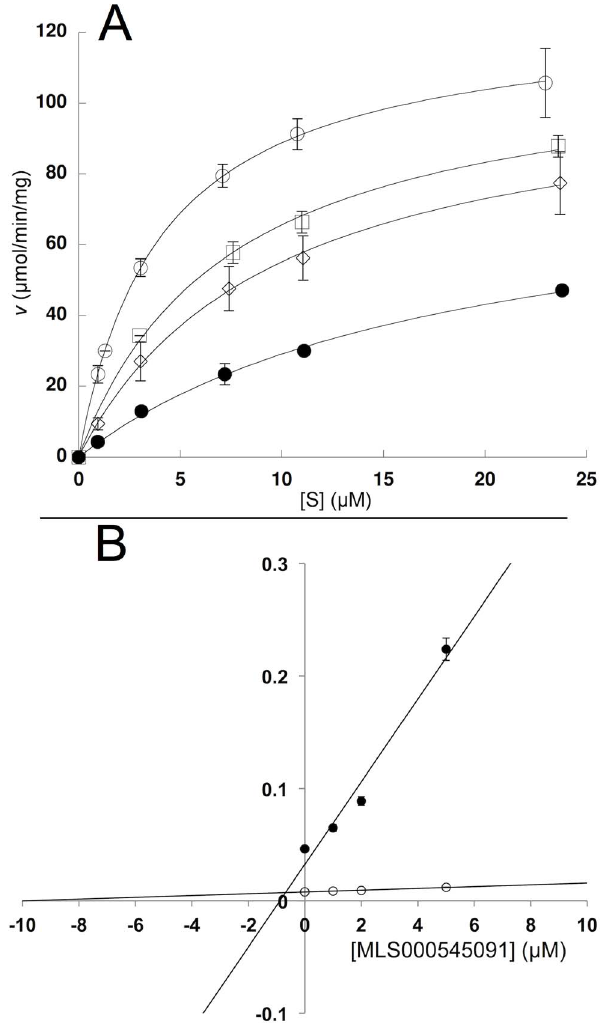
Figure 4. Steady-state kinetics data for the determination of K i and K i 9 for 15-LOX-2 with MLS000545091. (A) Initial enzymatic rate ( m mol/min/mg) versus substrate concentration ( m M) at inhibitor concentrations of 0 m M (open circles) 1 m M (open squares) 2 m M (open diamonds) and 5 m M (closed circles) fitted to the Henri–Michaelis– Menten equation to yield V max ( m mol/min/mg) and V max / K M (mol/min/ mg/ m M). All measurements were done in triplicate. (B) K M /V max replot (closed circles) (units are m M/ m mol/min/mg) versus [Inhibitor] ( m M), which yielded a K i of 0.9 + / 2 0.4 m M. 1/V max replot (open circles) (units are 1/ m mol/min/mg) versus [Inhibitor] ( m M), which yielded a K i 9 of 9.9 + / 2 0.7 m M, indicating weak mixed-type inhibition. compounds related to MLS000545091 were screened, with varying polarity and steric bulk of both ends of the molecule (Figure 3A). The majority had no activity, but one (MLS001007221) had comparable activity. Six compounds related to MLS000536924 were tested, varying the size and polarity of only one end of the molecule (Figure 3B). Of these six compounds, four had comparable potency to the parent compound, with one being approximately 4-fold more potent (MLS000550104). These data suggest that the parent inhibitors are not promiscuous 15- LOX-2 inhibitors and that it may be possible to improve their potency with further experimentation. We are currently exploring this line of inquiry.